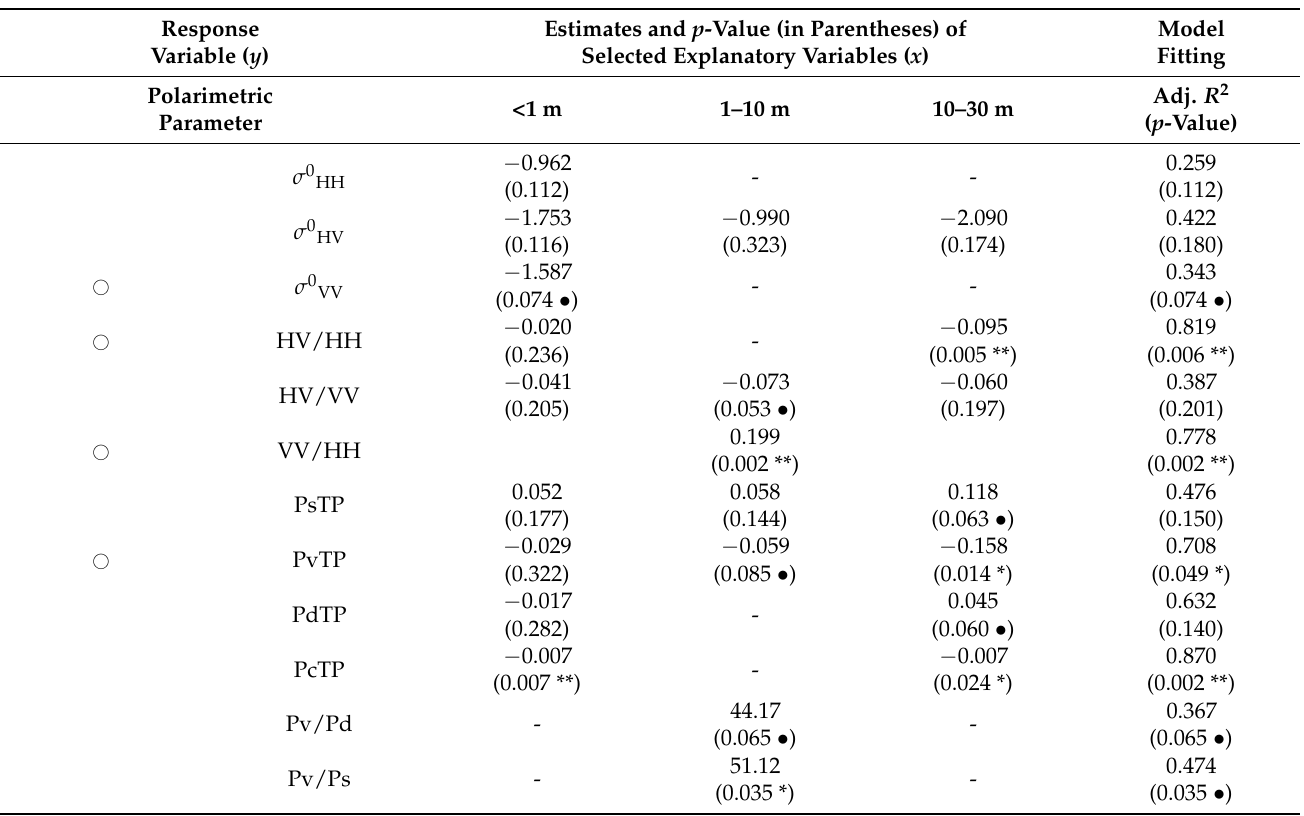
Table 4. Results of multivariate linear regression analysis between forest layer structures (explanatory variable) and polarimetric parameters from L-band SAR data (response variables). AIC-selected variables are shown with estimates, p -values are within parentheses, and a hyphen “-” indicates variables not selected in AIC stepwise selection. The overall adequacy of the model was assessed using adj. R 2 and p -value. Significance levels are denoted as follows: “ • ” is p < 0.100, “*” is p < 0.050, and “**” is p < 0.010.